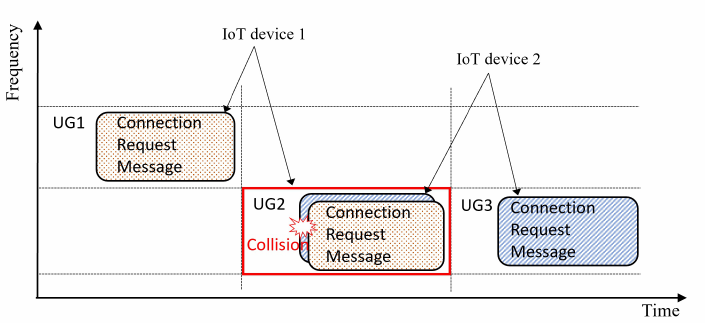
Figure 3. An example of message redundancy elimination when each IoT devices transmit dual connection request